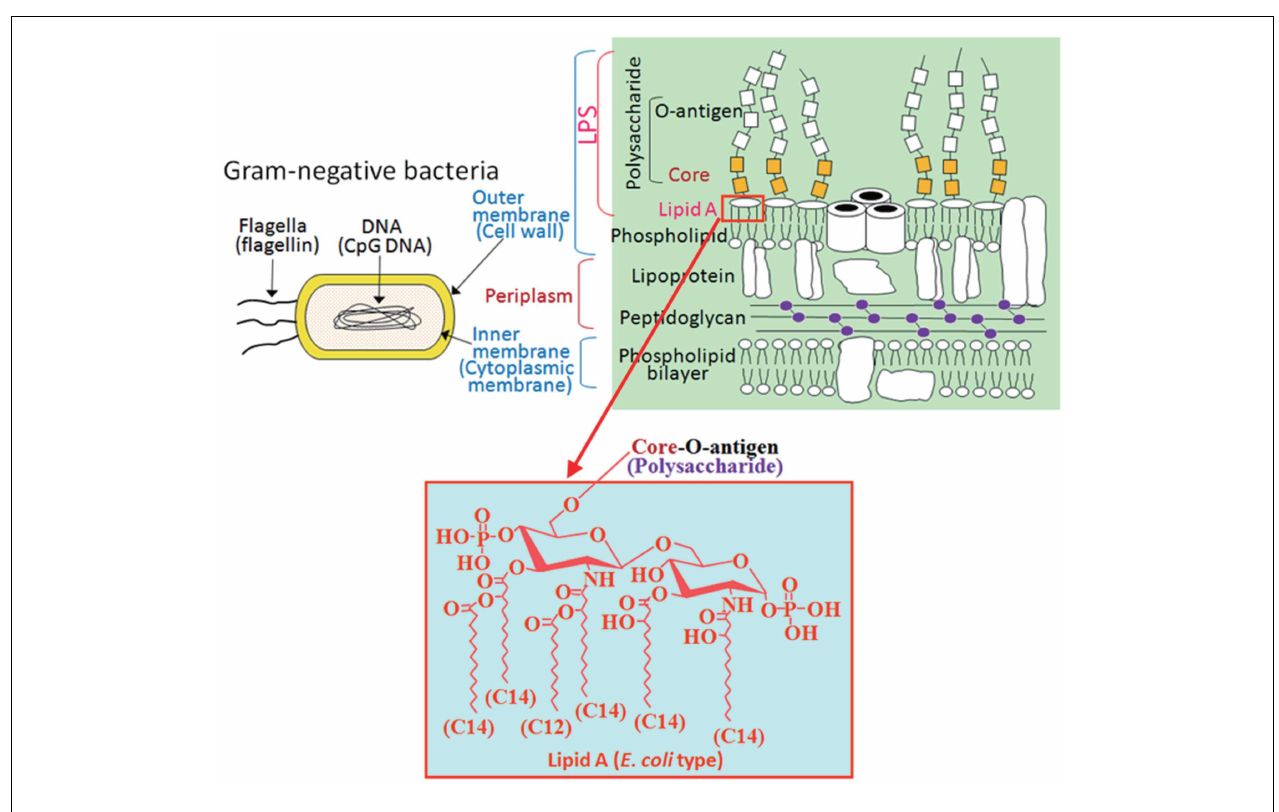
membrane anchor portion of LPS termed lipid A, but not the polysaccharide portion, is responsible for stimulation ofTLR4 signaling. E. coli type hexa-acylated lipid A, relatively conserved among a wide variety of Gram-negative bacteria, is the most potent structure that activates theTLR4